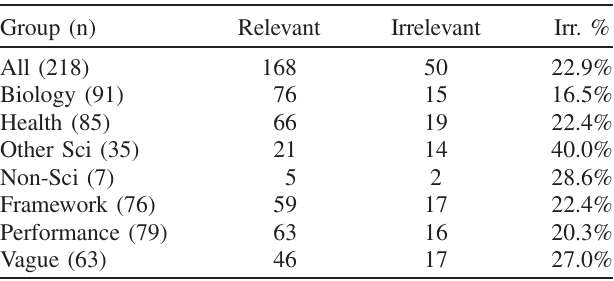
TABLE I. Distributions of students who saw the physics course as relevant in some way to their majors vs students who saw the course as irrelevant. Displayed both in terms of raw number and in terms of the percentage out of each group. Originally Table I from Ref. [14]. The term “ Irr. % ” in Table I refers to the percentage of each row ’ s student population that is in the “ Irrelevant ” group, i.e., they do not perceive any relevance of the course to their major.